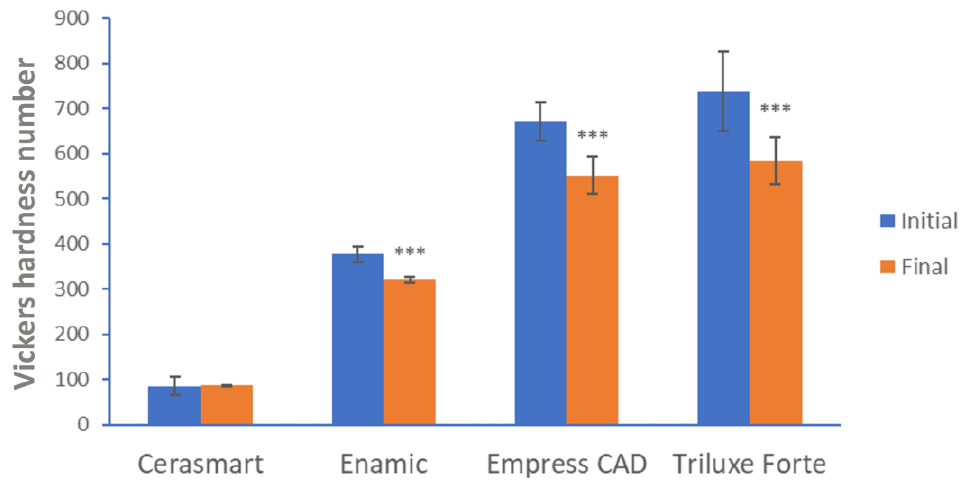
Figure 3. Comparison of microhardness values, before and after 18 h of immersion in simulated